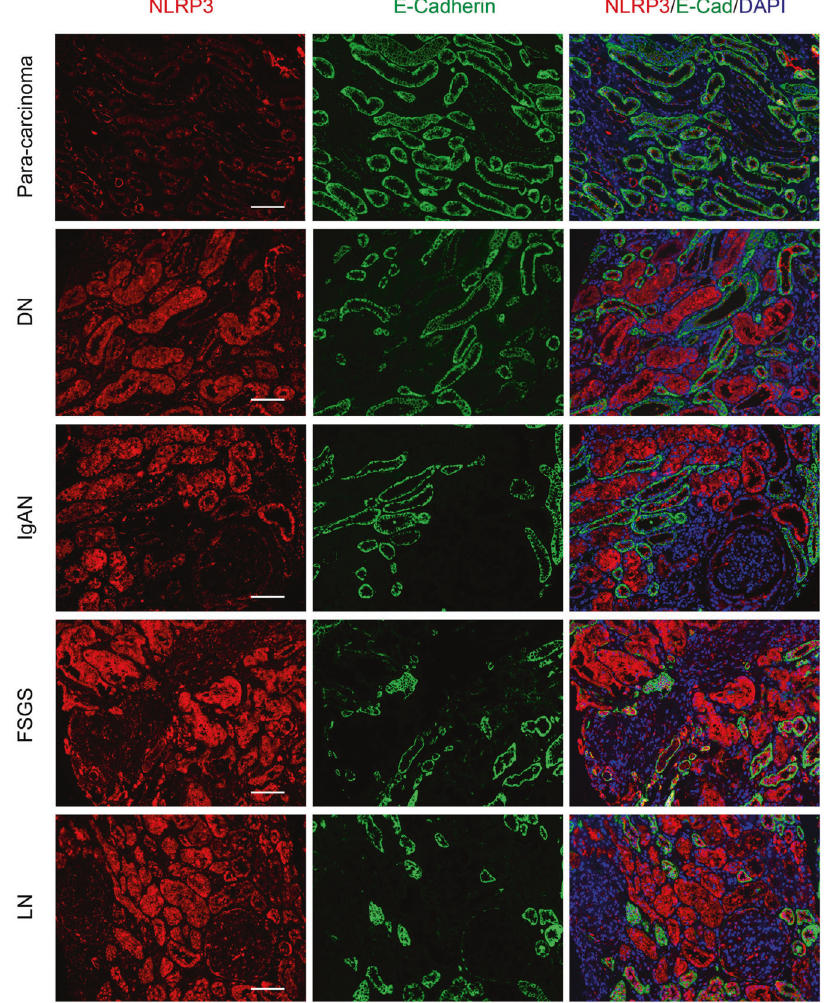
Fig. 5 Immuno fl uoresence of NLRP3 in a renal biopsy from CKD-V patients. Double immuno fl uorescence staining with NLRP3 and E-cadherin was performed in CKD-V renal biopsies including diabetic nephropathy (DN), IgA nephropathy (IgAN), lupus nephritis (LN), and focal segmental glomerulosclerosis (FSGS). Para-carcinoma was as controls. Bar = 20 mm. CKD-V chronic kidney disease stage